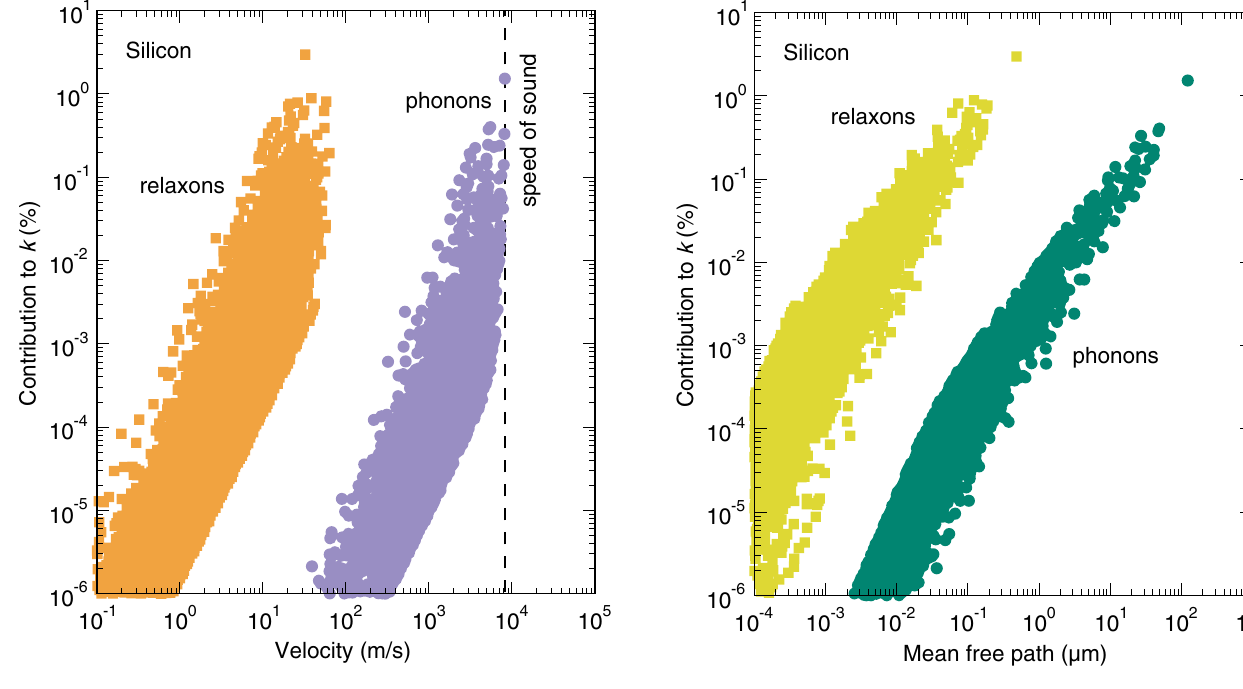
FIG. 7. Same as in Fig. 4 but for silicon, the comparison of relaxons and phonon velocities and their contributions to room- temperature thermal conductivity. Similar to the case of graphene, the velocity of the SMA description is set by the velocity of phonons, with long-wavelength acoustic modes (those with the highest velocities) giving the largest contributions. Relaxon velocities are instead smaller by about 2 orders of magnitude, indicating that the heat flux is slowed down by the action of phonon scattering.